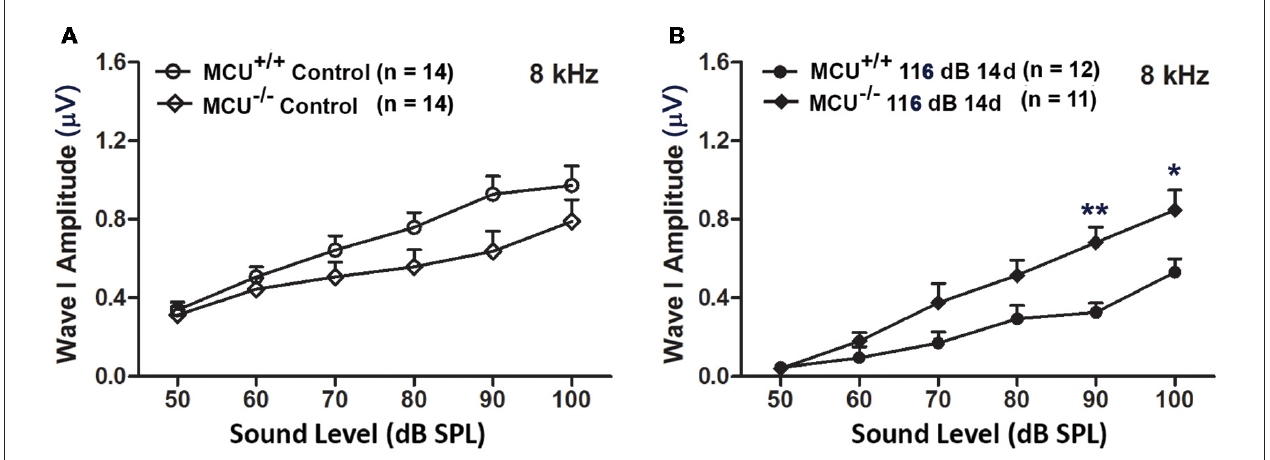
FIGURE 8 | MCU knockout mice were resistant to reduction in their ABR wave I amplitudes at 8 kHz measured 14 days after noise exposure. (A) There was no significant difference in wave I amplitudes between MCU − / − and MCU + / + mice without noise exposure. (B) MCU knockouts were significantly resistant to reduction in ABR wave I amplitudes after noise in comparison to wild-type littermates at sound intensities of 90 and 100 dB SPL. Data are shown as means ± SEM, ∗ p < 0.05, ∗∗ p < 0.01. n indicates the number of mice; one cochlea was used per